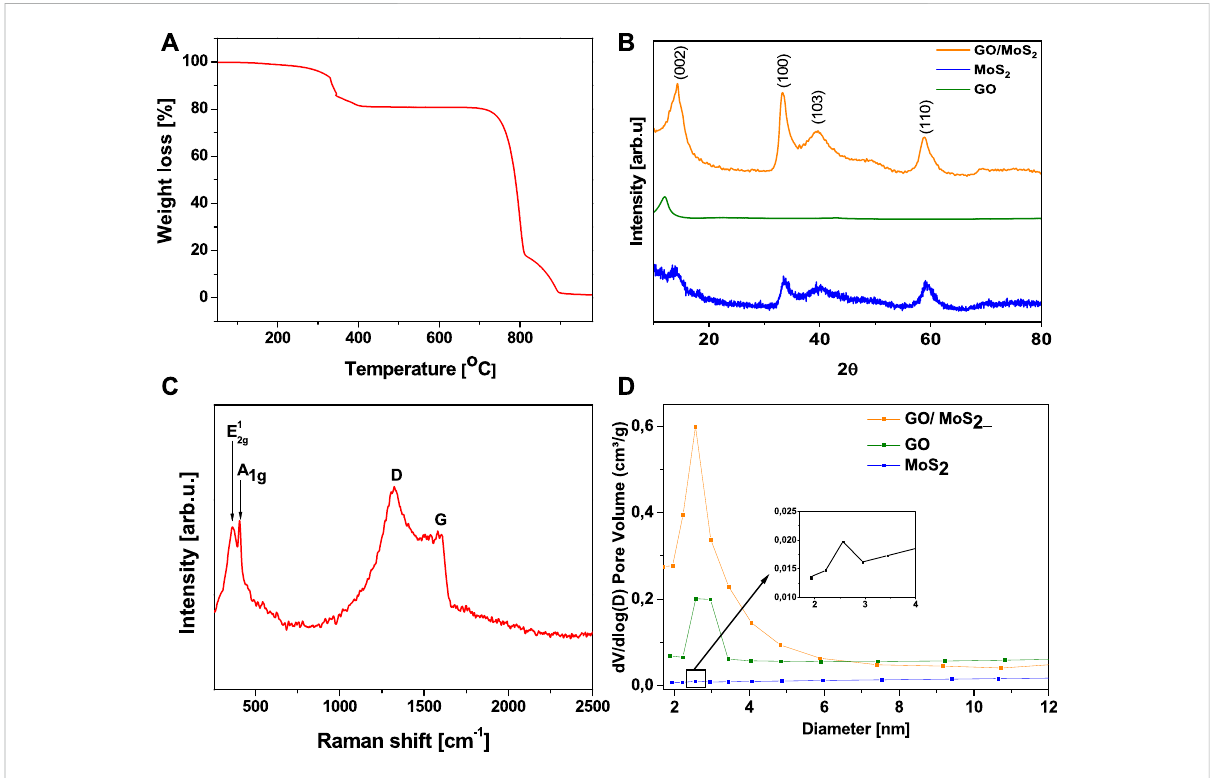
FIGURE 3 TGA pro fi le (A) , XRD pattern (B) , Raman spectrum (C) and BJH pore size distribution of GO, MoS 2 , and GO/MoS 2 (D)